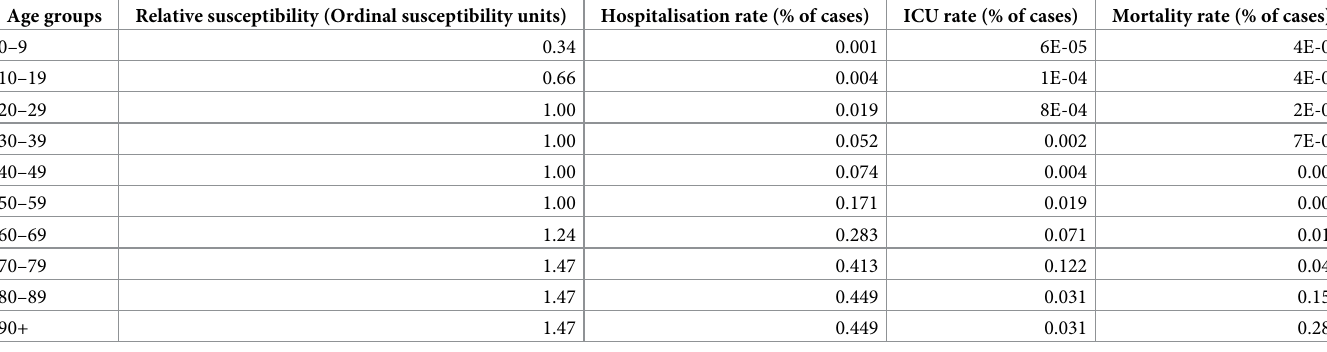
Table 3. Age distribution of key epidemiological